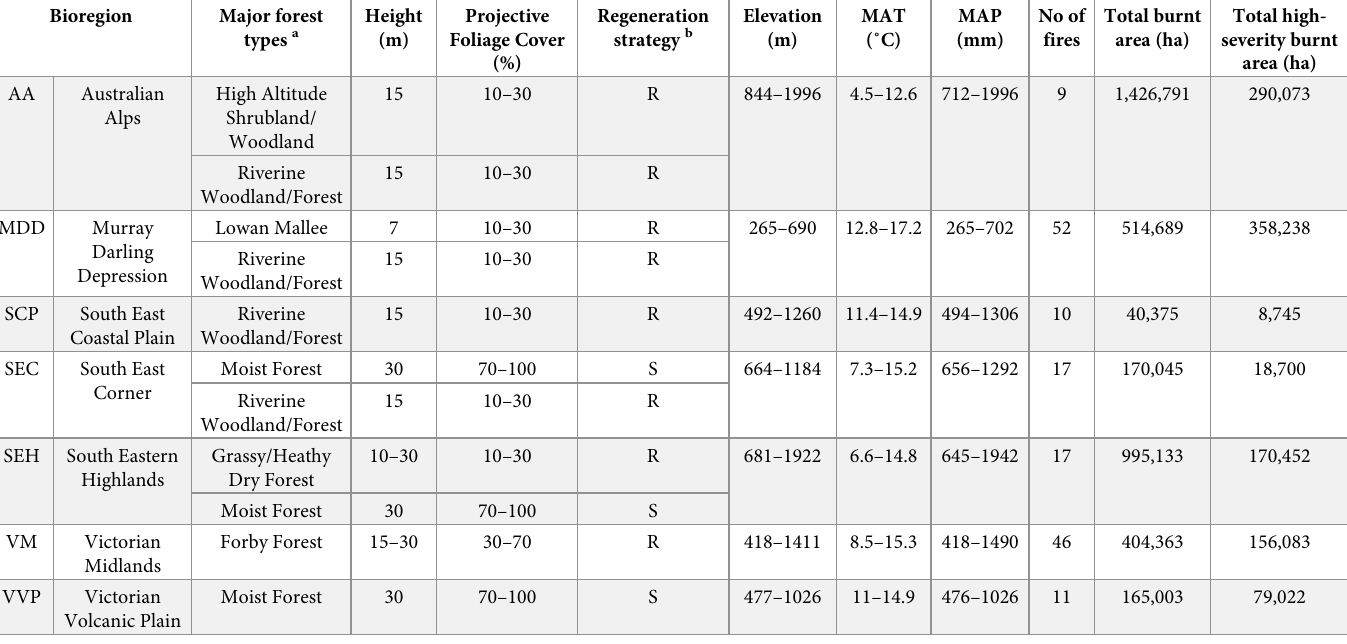
Table 1. Characteristics of the bioregions in the study area affected by the selected 162